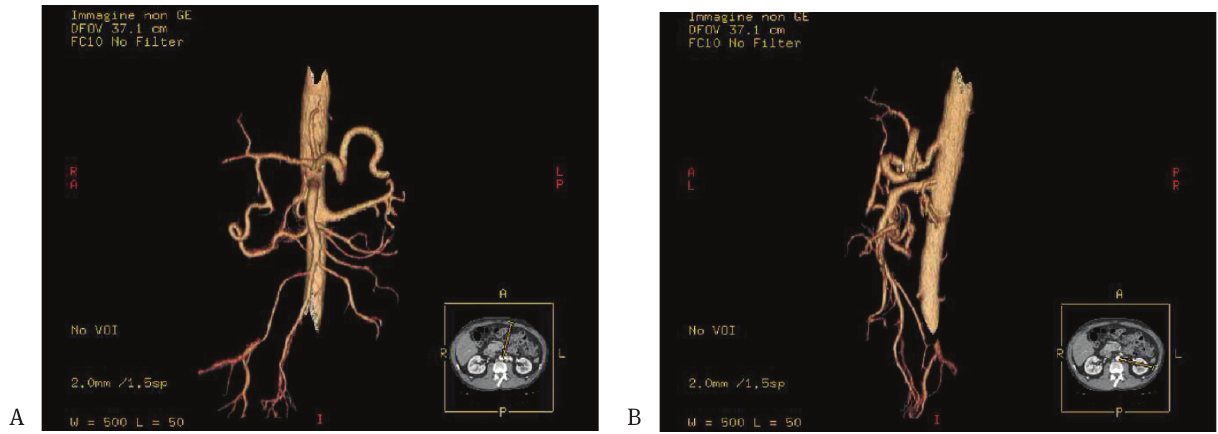
A Figure 4 a-b: CT scan showed restoration of an adequate flow celiac artery